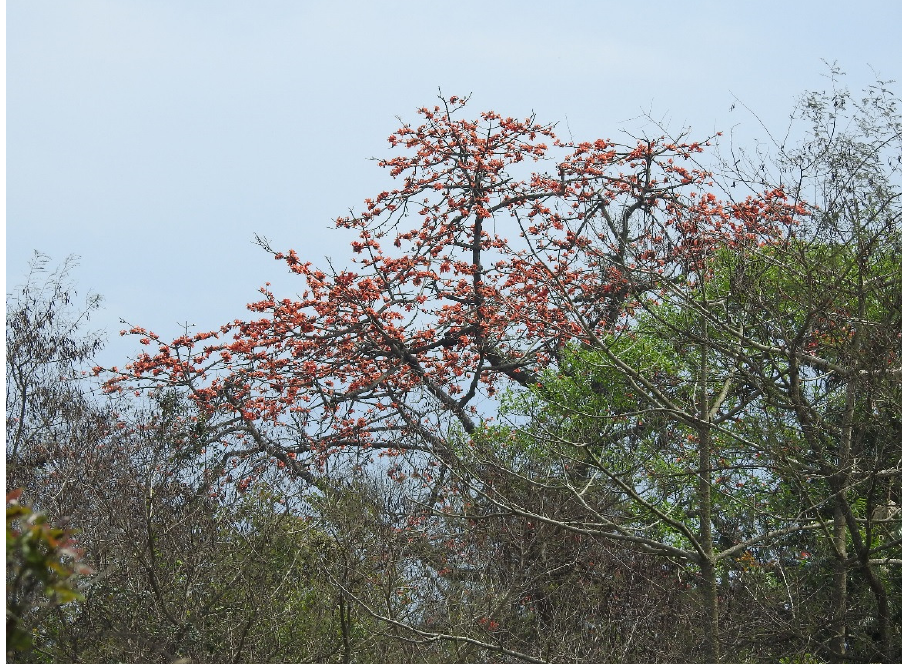
Figure 12. Treescape of a moist deciduous tropical forest having a silk cotton tree Bombax ceiba with red flowers. This is very common and one of the most favoured trees for nesting, generally by White-rumped